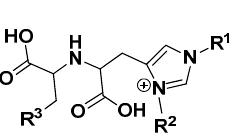
Figure 2. Scaffold general structure for Angiotensin Converting Enzyme 2 ACE2 inhibitors from Dales and Torres.